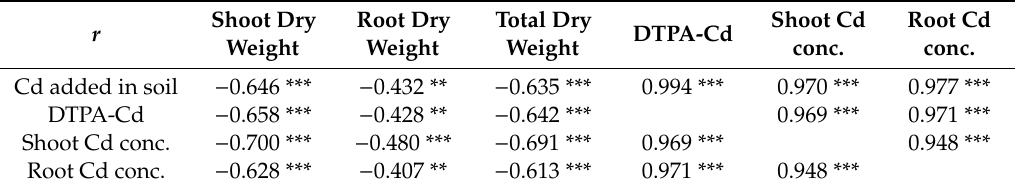
Table 5. Pearson correlation coe ffi cient ( r ) between soil and plant parameters. Significant